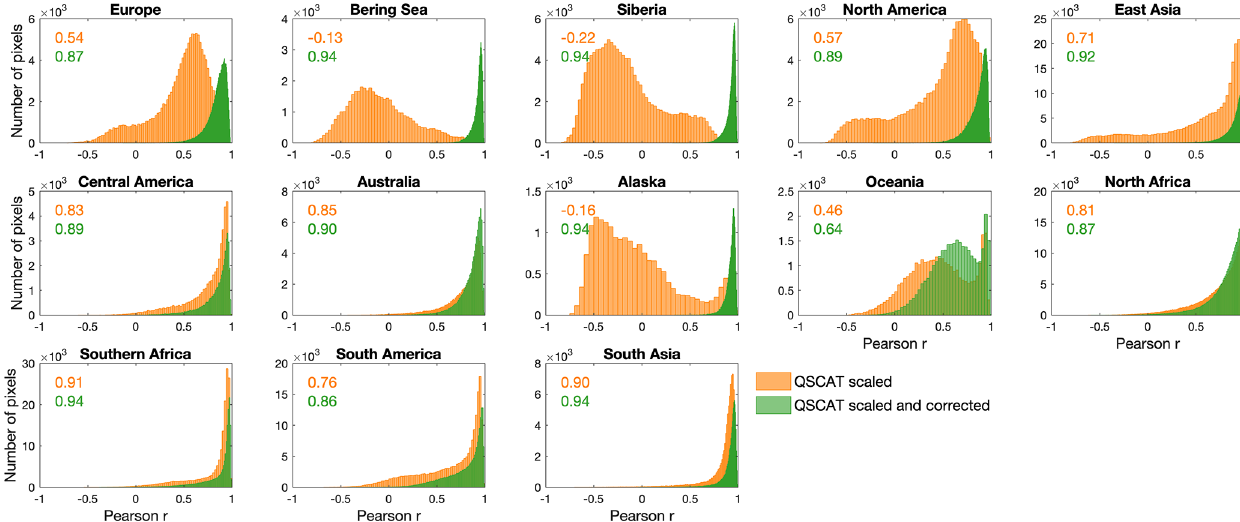
Figure 6. Pearson r -based quality assessment of the LHScat data set at the pixel level. Each panel shows the result of one region. Inside each panel, the Pearson r values between the C-band and the scaled Ku-band signals in the overlapping years (1999–2001 and 2007–2009) were calculated for all pixels and coloured in orange. As a comparison, the Pearson r values between the C-band and the corrected Ku-band signals in the overlapping years were also calculated and coloured in green. The medians of the Pearson r values are labelled in each panel.